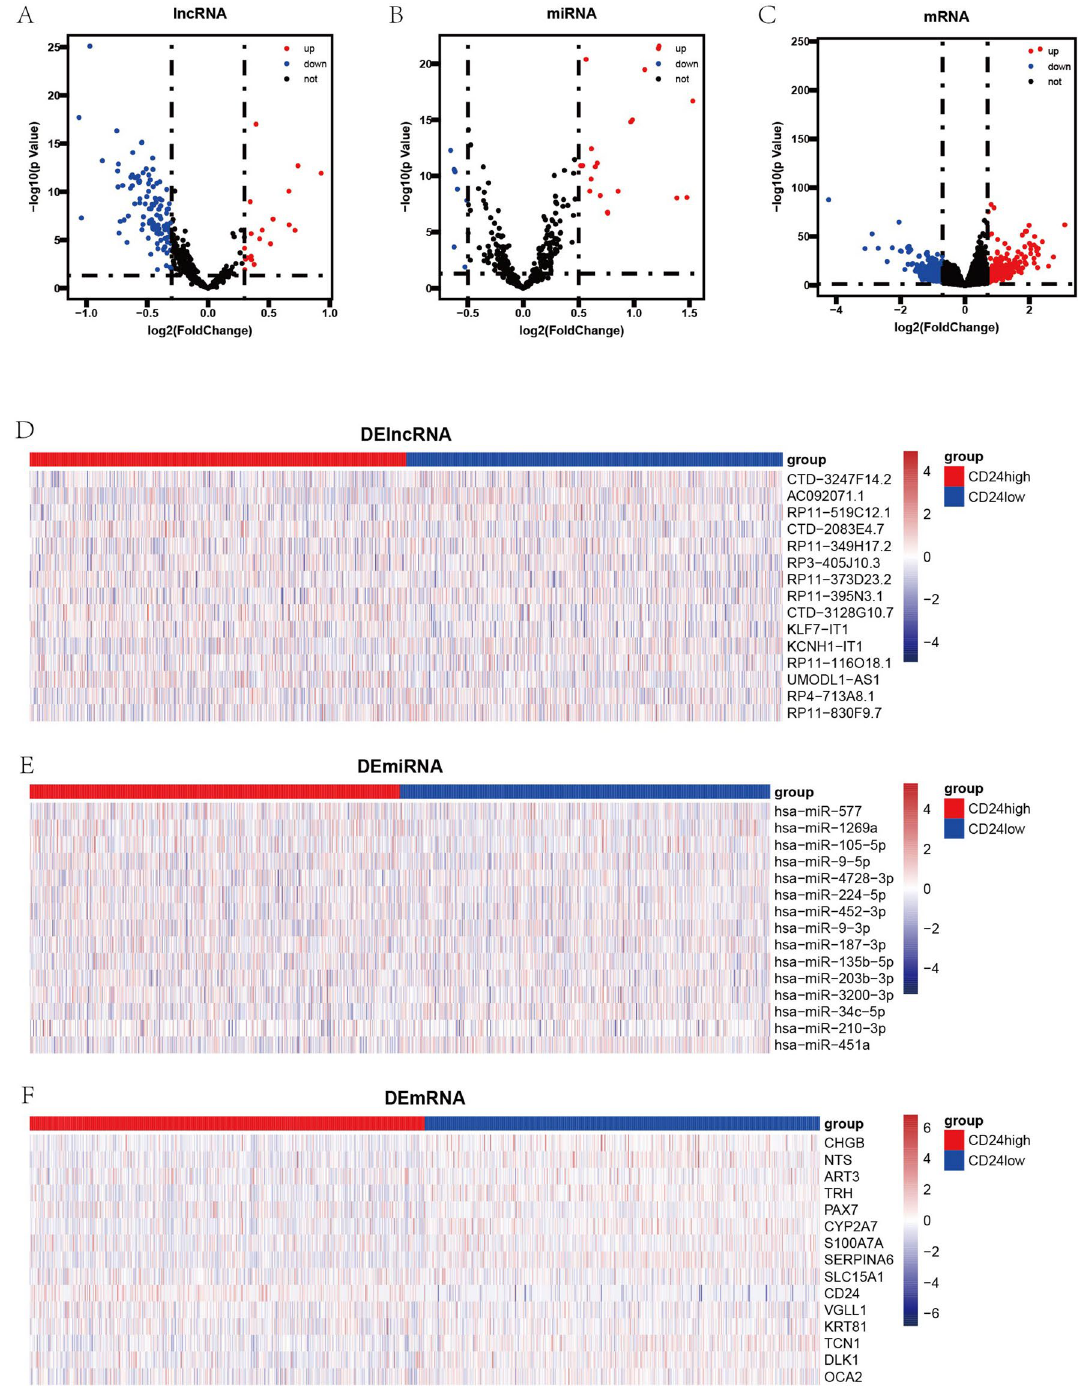
Figure 3. Differential expression analysis between tumor samples with high expression of CD24 and low expression of CD24. ( A – C ) Volcano maps of 132 DElncRNAs (p < 0.05 and |log2 fold change| > 0.3), 26 DEmiRNAs (p < 0.05 and |log2 fold change| > 0.5), 602 DEmRNAs (p < 0.05 and |log2 fold change| > 0.7). ( D – F ) Heatmaps of top 15DElncRNAs, DEmiRNAs and DEmRNAs (sorted by p